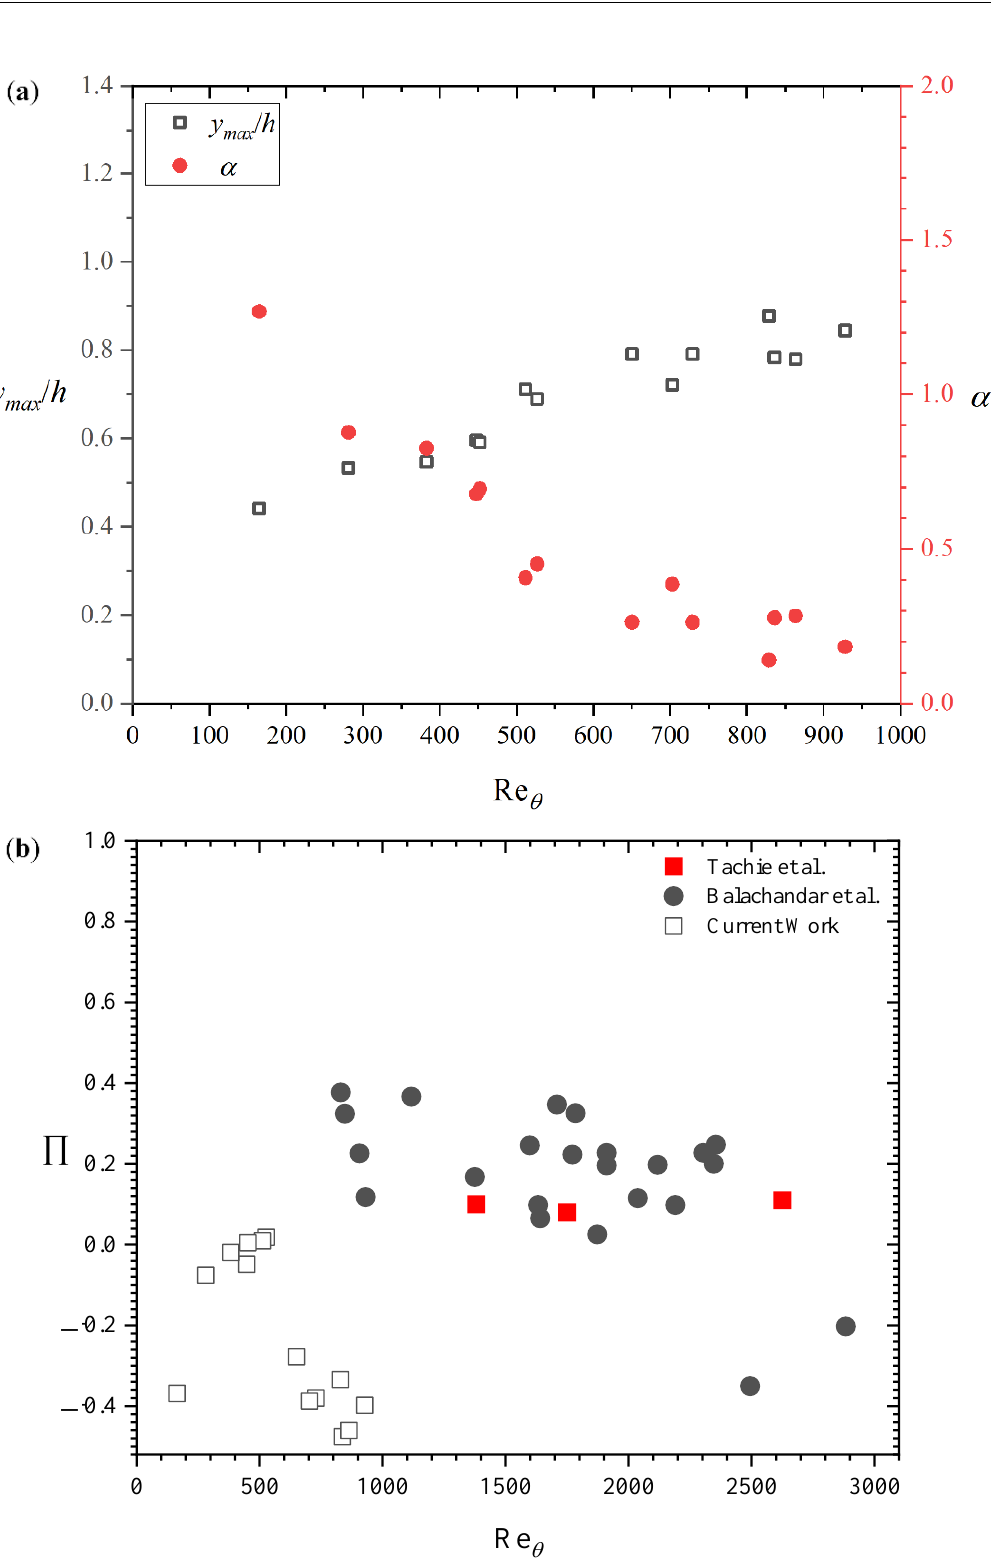
Figure 7. ( a ) Dependence of the location of the maximum streamwise mean velocity y max on Re θ , shown in dimensionless parameters ( y max / h and a dip correction factor α = h / y max − 1 ). ( b ) Cole’s wake parameter for current test data compared with other open-channel flow studies (Tachie et al. I [4] and Balachandar et al. [21]).